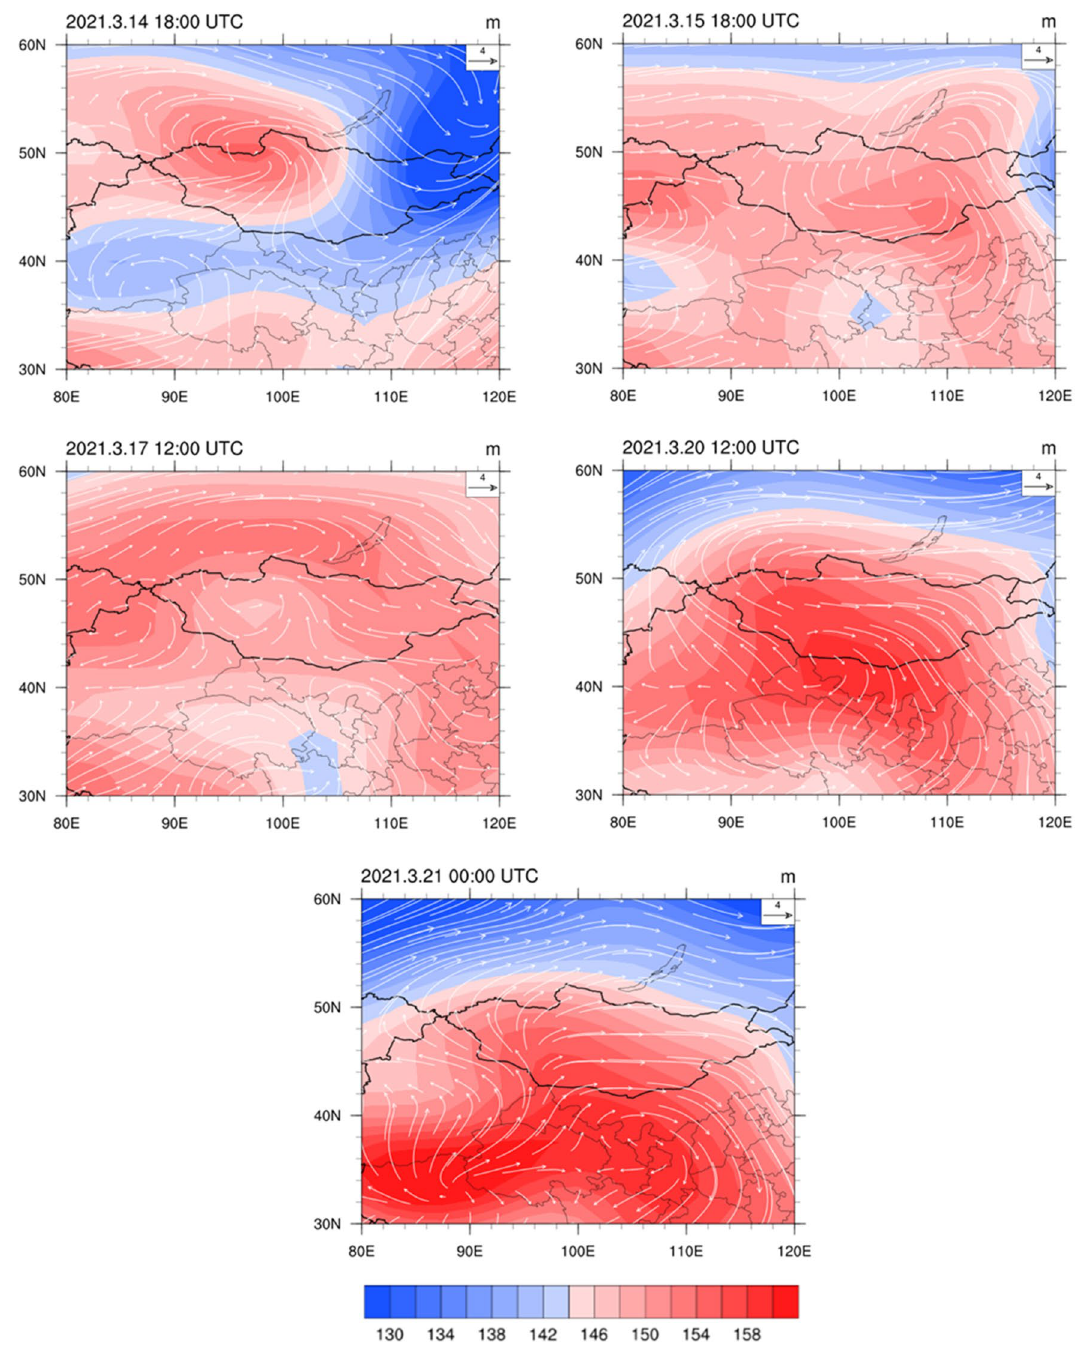
Figure 7. 850 hPa geopotential height field and wind vector field of a typical dust storm from March 14, 2021, to March 20, 2021 (NCAR Command Language https:// www. ncl. ucar.